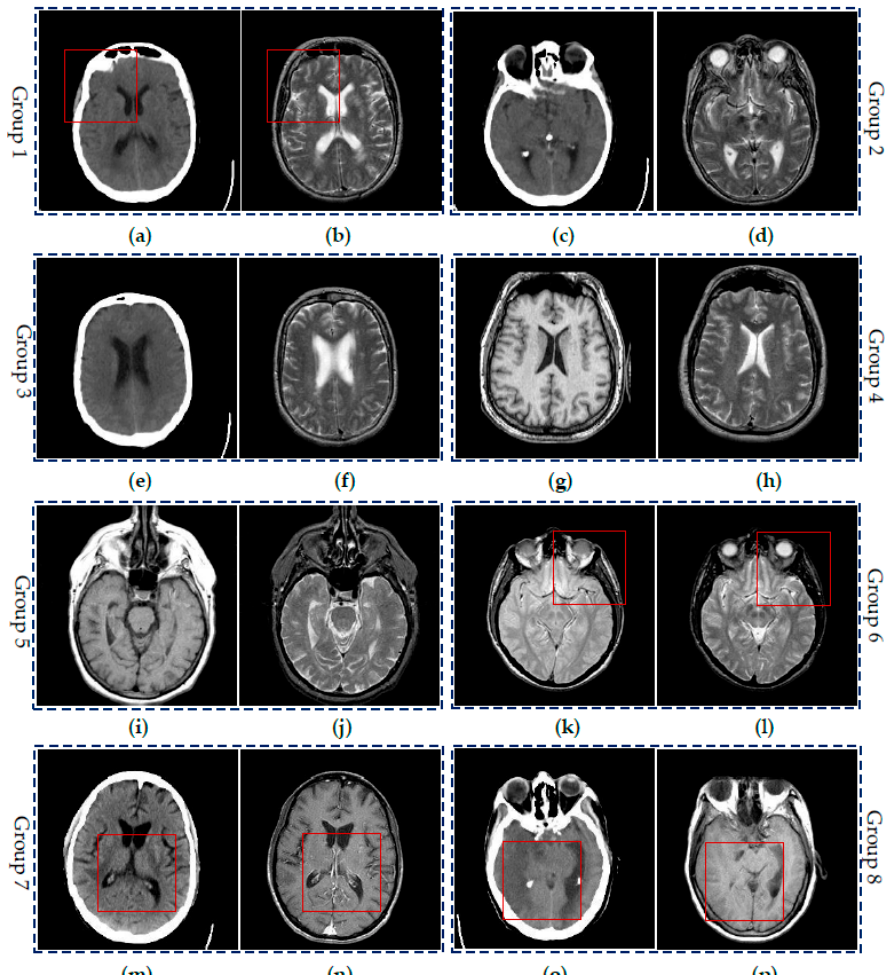
Figure 6. Six groups of source medical images: ( a , c , e , m , o ) CT images; ( b , d , f , h , j , l ) MR-T2 images; ( g , i , p ) MR-T1 images; ( k ) MR-PD image; and ( n ) MR-GAD image.